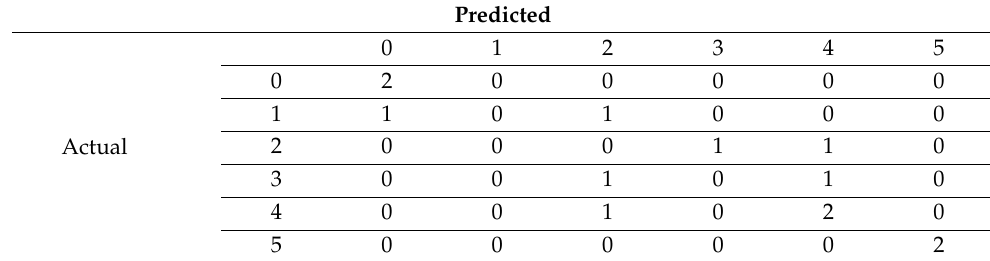
Table 10. Weighted KNN; Accuracy